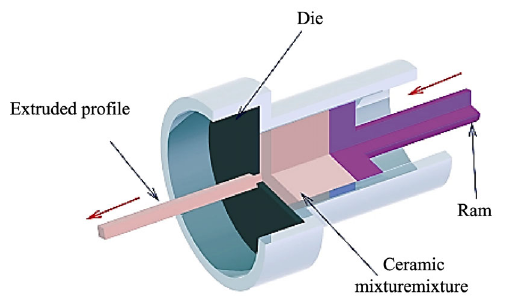
Fig. 21 Schematic diagram of the extrusion